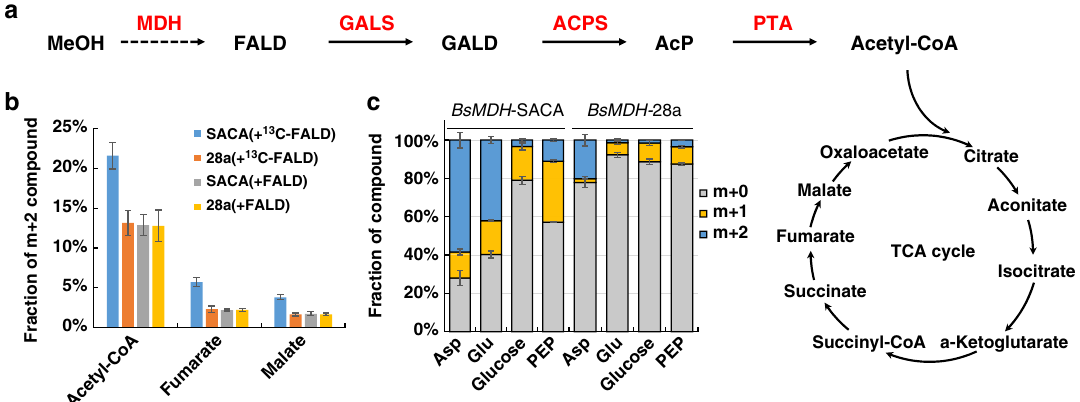
Fig. 6 13 C-labeled metabolic tracer analysis of the SACA pathway. a Schematic diagram of the tested pathway for 13 C-labeled tracer. b The fraction of m + 2 compounds in cellular lysates with 13 C-labeled or unlabeled formaldehyde. c The fraction of 13 C-labeled metabolites. Cells were induced in LB and transferred to M9 medium containing 13 C-labeled methanol. Intracellular metabolites were detected after 16 h incubation and proteinogenic amino acids were measured after 26 h incubation. The sum of the detected isotopomers was set as 100%. 13 C-FALD 13 C-labeled formaldehyde, m + 0 without 13 C labeling, m + 1 single 13 C labeling, m + 2 double 13 C labeling, FALD formaldehyde, MeOH methanol, GALD glycolaldehyde, AcP acetyl-phosphate, Asp aspartate, Glu glutamate, PEP phosphoenolpyruvate, SACA the strain contains the vector GALS-ACPS-PT A-28a, 28a the strain contains the empty vector of 28a, BsMDH -SACA the strain contains both BsMDH -pCDF and GALS - ACPS - PTA -28a vectors, BsMDH- 28a: the strain contains both BsMDH -pCDF vector and the empty vector 28a. Error bars represent s.d. (standard deviation), n = 3. Source data are provided as a Source Data fi le.